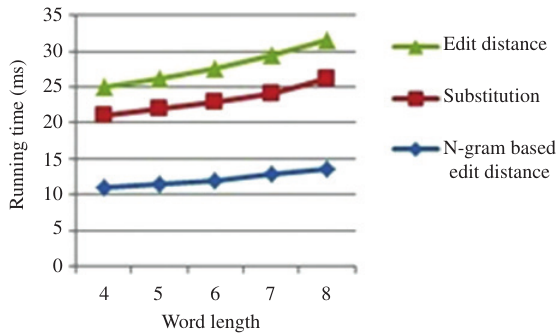
Figure 7: Comparison of the Running Time in the Various Methods.